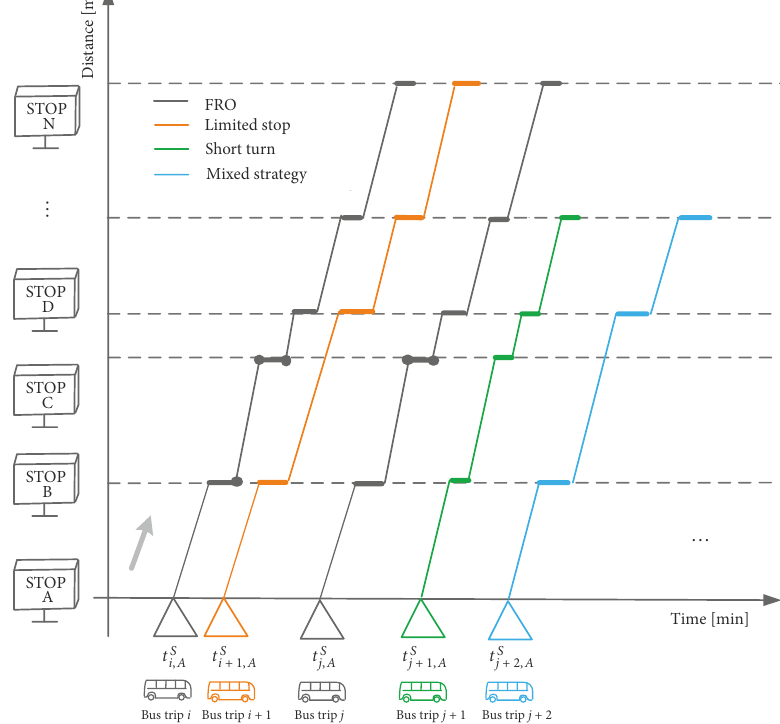
Figure 1. Space-time diagram of operational strategies of a bus single line at given operation